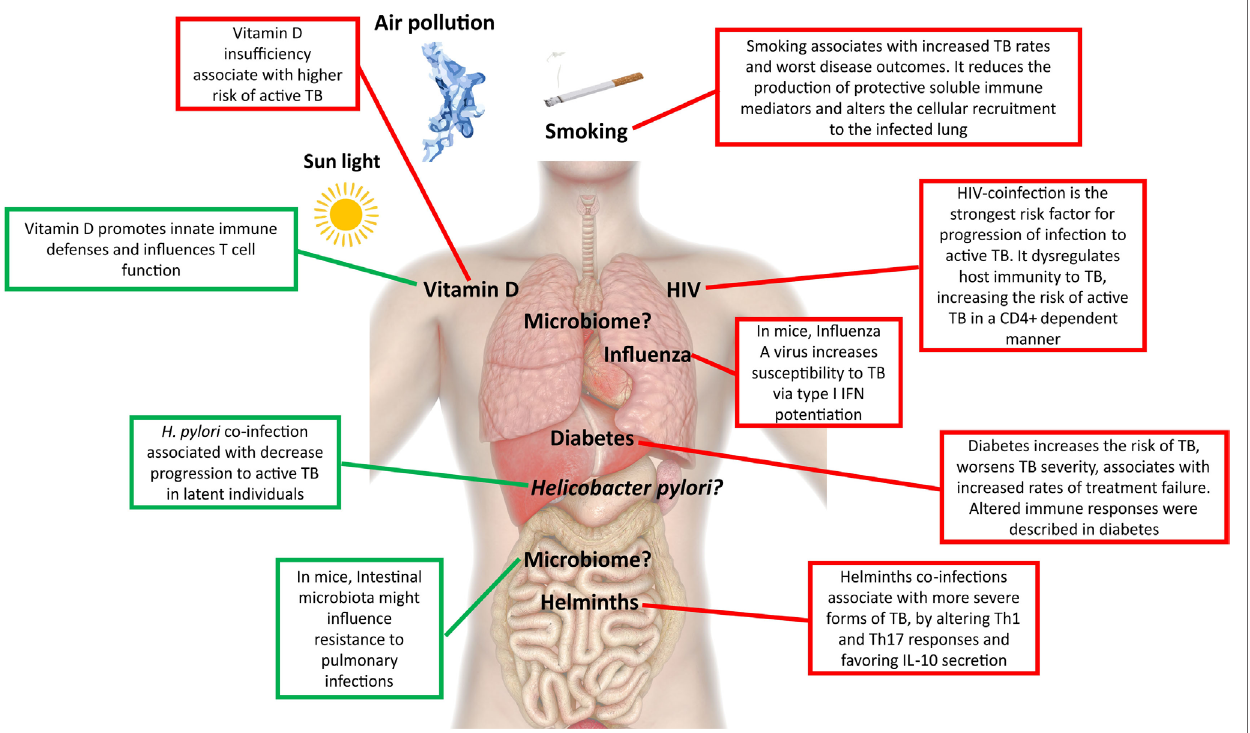
FigURe 2 | Extrinsic factors associated with active tuberculosis (TB). This figure depicts extrinsic factors associated with protection to active TB (green) or susceptibility/increased risk (red) for active TB